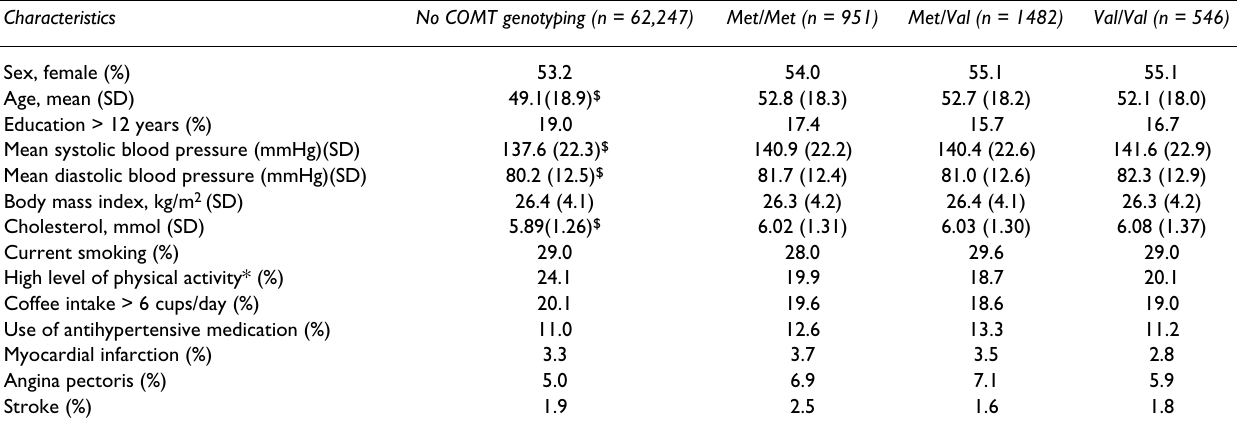
Table 2: Clinical characteristics of the subjects according to COMT genotypes. Characteristics